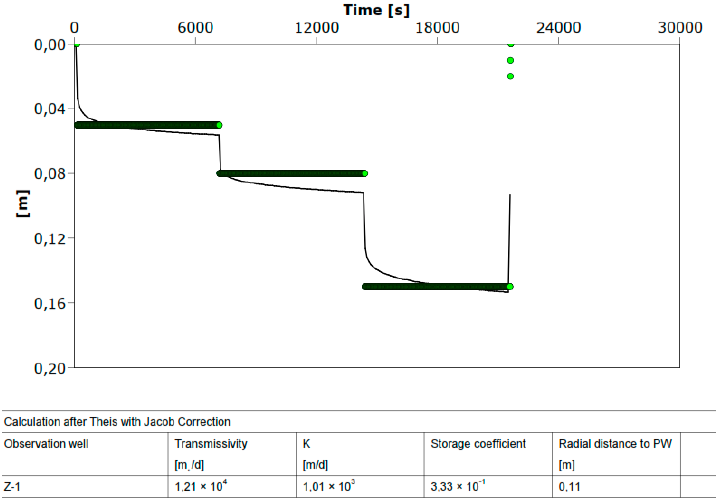
Figure 17. Aquifer parameters obtained at well Z-1, step test (4 April 2017).